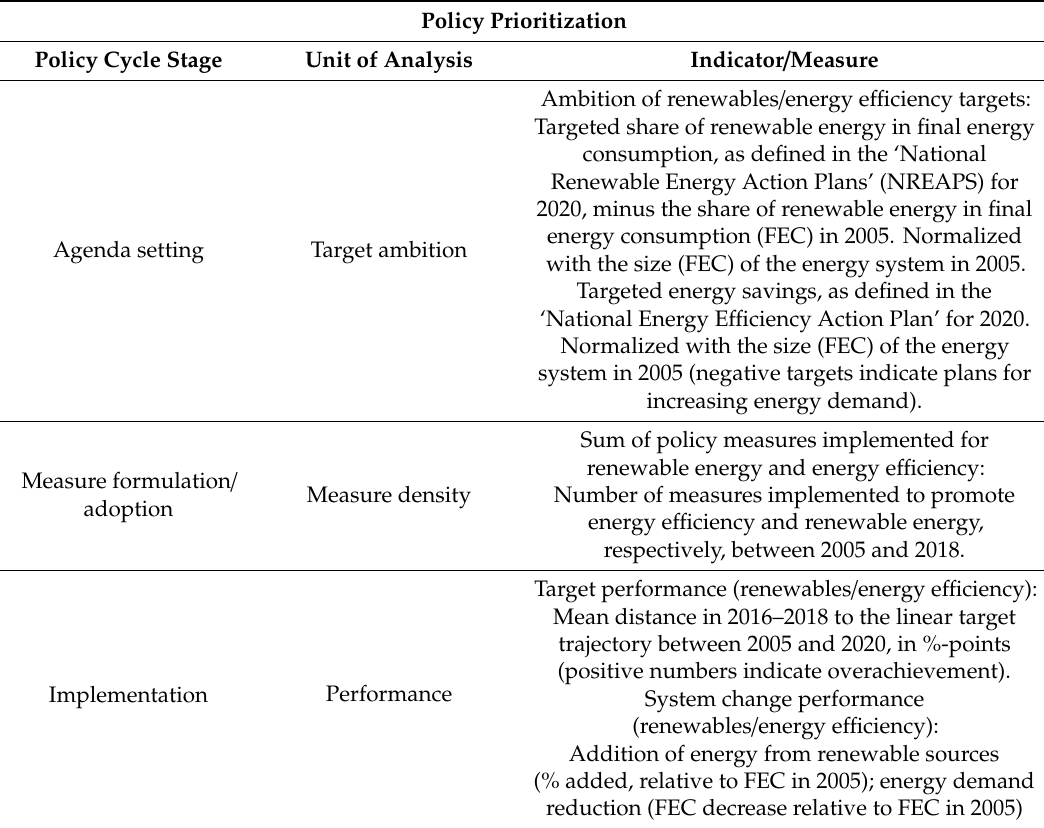
Table 1. Measurement of policy prioritization: conceptualization and